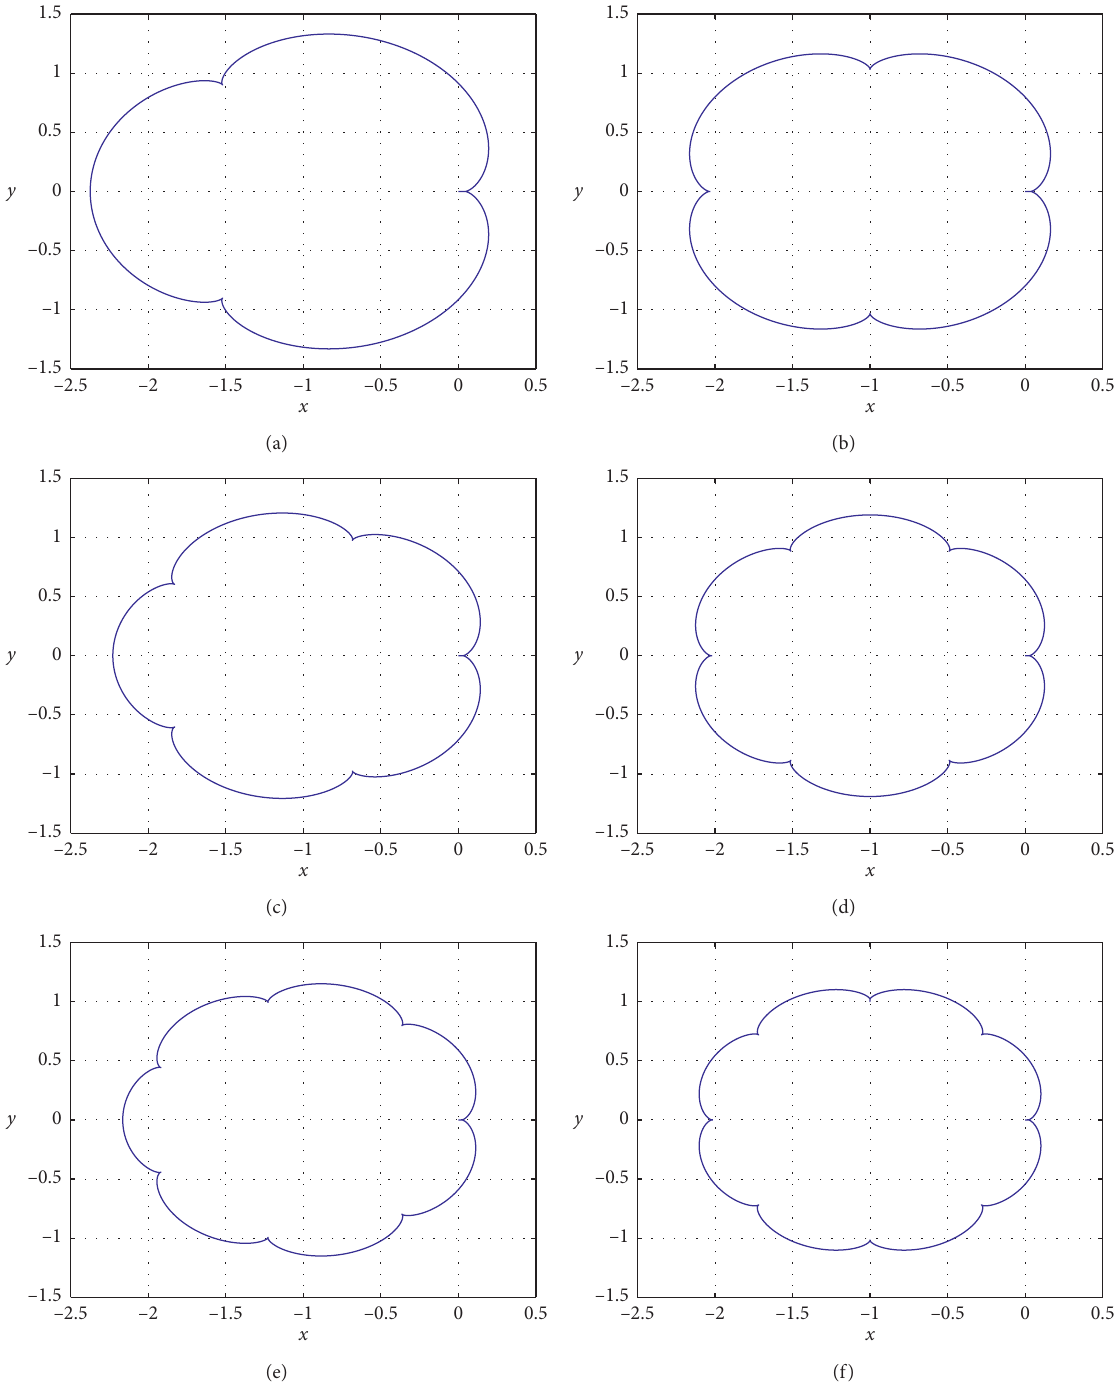
Figure 5: Periodic orbits when e � 0 . 1, f 0 � π /2, and velocity _ y 0 � 0 . 002. (a) Three-loop orbit, when x 0 � 0.041398075500. (b) Four-loop orbit, when x 0 � 0.032620475000. (c) Five-loop orbit, when x 0 � 0.0268523875. (d) Six-loop orbit, when x 0 � 0.0227732155. (e) Seven-loop orbit, when x 0 � 0.0197361. (f) Eight-loop orbit, when x 0 �